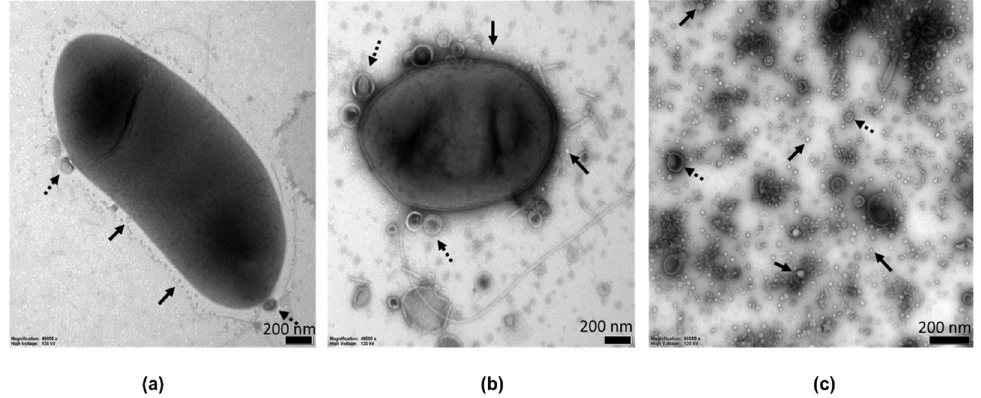
Figure 1. Membrane vesicles (MVs) from P. zantedeschiae 9M culture. TEM of bacteria grown on ( a ) the MH agar supplemented with 10% sucrose and ( b ) the CVP agar. Solid arrows indicate small MVs of 10–30 nm size budding off from the cells. Dashed arrows indicate large vesicles of about 50-100 nm in diameter. The size bar is 200 nm. ( c ) TEM images of purified MVs derived from a planktonic culture of P. zantedeschiae 9M grown in the M63 medium supplemented with 0.2% glycerol and 0.4% PGA. Solid arrows indicate two distinct subpopulations of MVs of sizes 10–30 nm and 100–300. Dashed arrows indicate vesicles with a double membrane, similar to O-IMVs. The size bar is 200 nm.